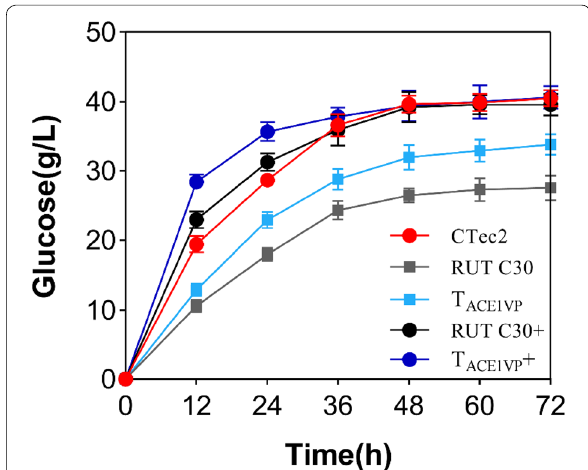
Fig. 6 Hydrolysis of corn stover by CTec2 and by the crude enzyme from T ACE1VP or RUT C30. The crude enzymes from T ACE1VP or RUT C30 were either supplemented with β-glucosidase (Sunson Enzymes) (T ACE1VP , RUT C30 ) or not supplemented with β-glucosidase + + (T ACE1VP , RUT C30) at the CBU/FPA ratio of 2. Commercial cellulase CTec2 (Novozymes, Bagsvaerd, Denmark) served as the control. Enzymatic hydrolysis was performed at 15 FPA/(g pretreated corn stover). Values represent the mean and standard deviation